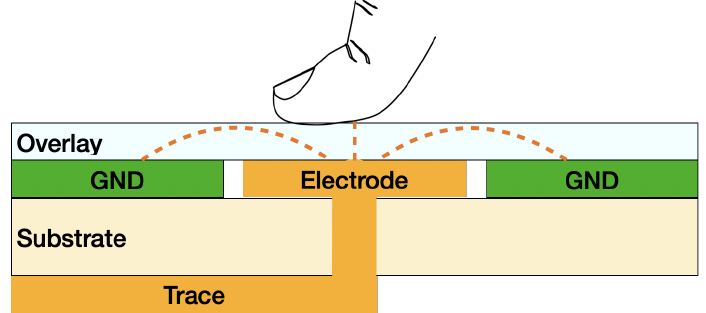
Figure 5. Schematic structure of a